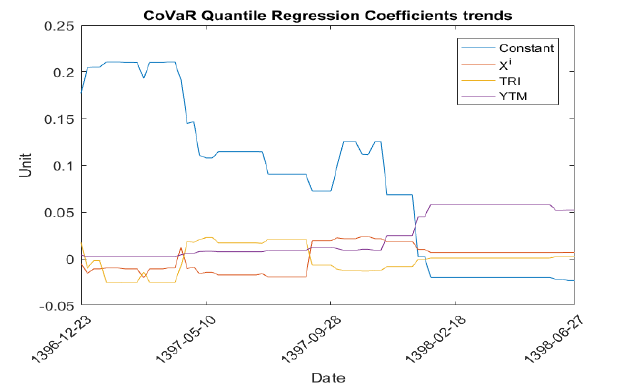
Figure 2. Over-Time Trend of Quantile Regression